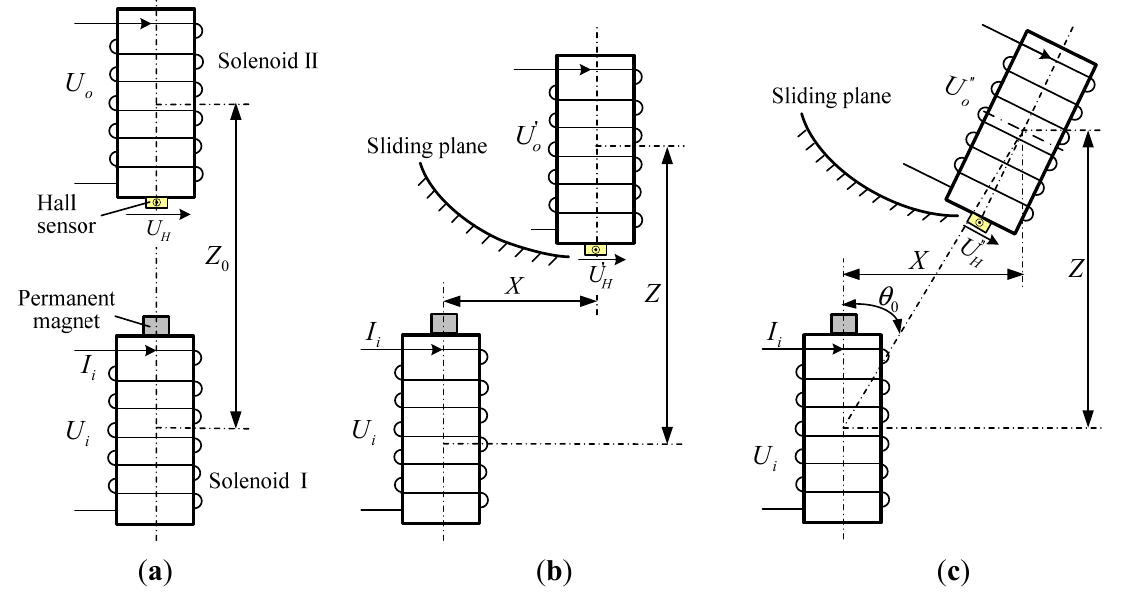
Figure 2. Geometrical arrangement between two arbitrary adjacent solenoids: ( a ) Initial arrangement; ( b ) Relative horizontal displacement and vertical displacement occurred; ( c ) Relative tilt, horizontal displacement and vertical displacement